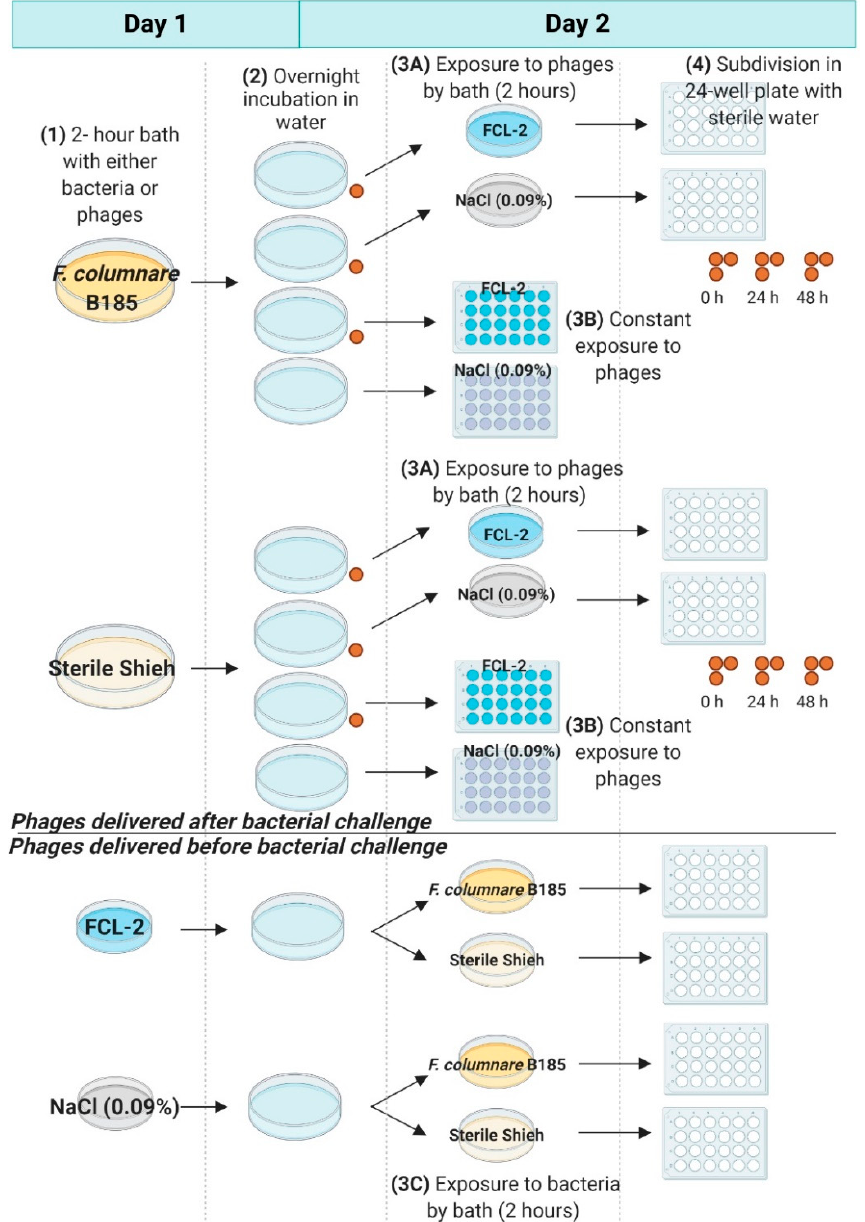
Figure A2. Exp. II section C: experimental set up. Rainbow trout eyed eggs were exposed to phages after (upper panel) or before bacterial challenge (lower panel). ( 1 ) Eyed eggs were bathed for 2 h with F. columnare B185 (5.0 × 10 6 CFU mL − 1 ) or sterile Shieh medium (upper panel) in 140 mm Ø Petri dishes (97–99 eggs per dish–100 mL volume), and with the phage FCL-2 (2.5 × 10 7 PFU mL − 1 ) or NaCl (0.09%) (lower panel) in 90 mm Ø Petri dishes (24 eggs per dish–35 mL volume). ( 2 ) Eggs were moved into 140 mm Ø Petri dishes (22–25 eggs per dish–100 mL volume) with water and incubated overnight. ( 3 ) Eyed eggs previously exposed to F. columnare were either ( 3A ) bathed for 2 h or ( 3B ) moved directly into 24-well plates in either FCL-2 phage solution (2.5 × 10 7 PFU mL − 1 ) or NaCl (0.09%) (24 eggs per group) (upper panel). ( 3C ) Eyed eggs previously exposed to phages were bath-exposed to F. columnare strain B185 (5.0 × 10 6 CFU mL − 1 ) or sterile Shieh medium for 2 h (12 eggs per group) (lower panel). Bath exposures to either phages or bacteria were performed in 90 mm Ø Petri dishes (35 mL volume). ( 4 ) Following the 2 h bath, eyed eggs were transferred into 24-well plates containing 2 mL of water (one per well). Eyed eggs were sampled during the experiment as indicated by the round orange circles resembling trout eyed eggs. h = hours post phage exposure. Created with Biorender.com (the figure was exported under a paid license